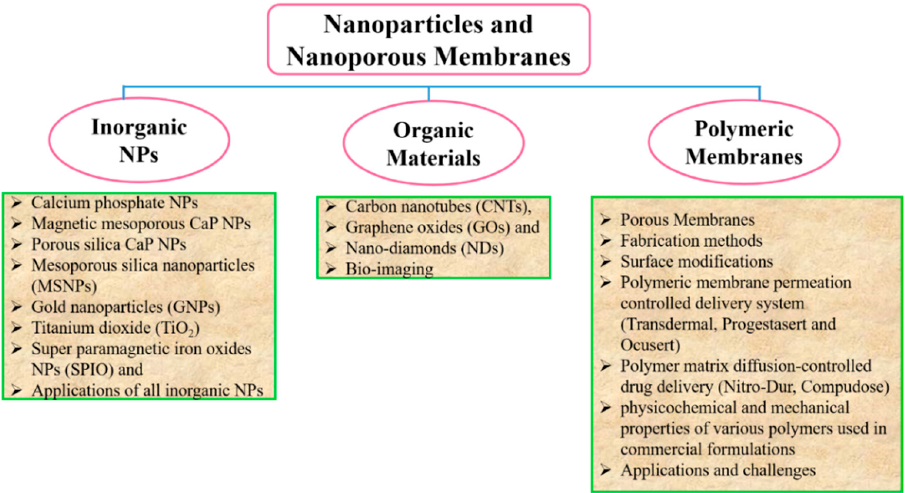
Figure 2. Structural overview of the article.